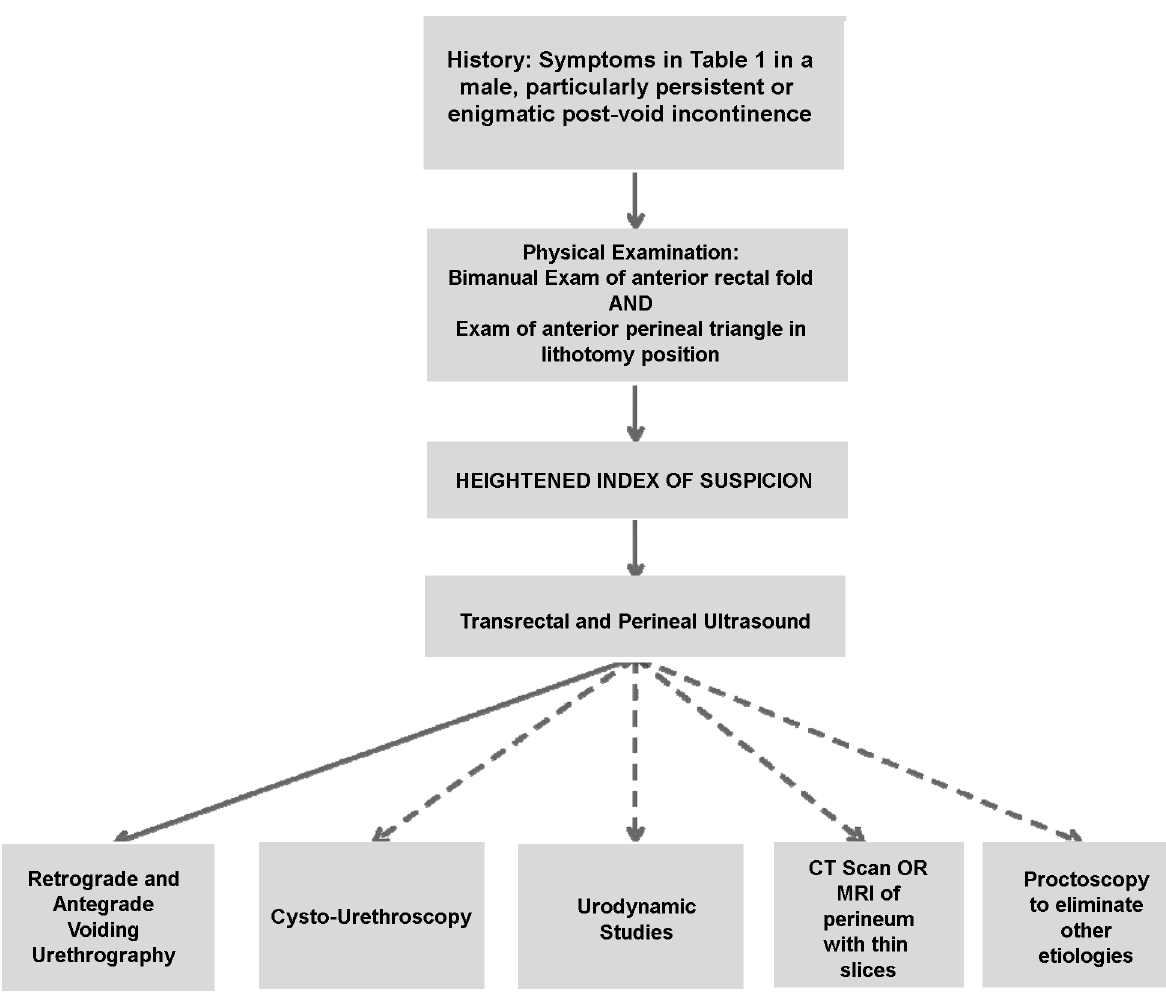
Figure 1 – Recommended diagnostic algorithm for testing. If the patient is positive for the symptoms in Table-1 after history and physical exam, syringocele can be suspected. Ultrasonography should be followed by urethrography to reliably detect syringoceles. The dashed arrows indicate the tests that are not usually necessary to diagnose